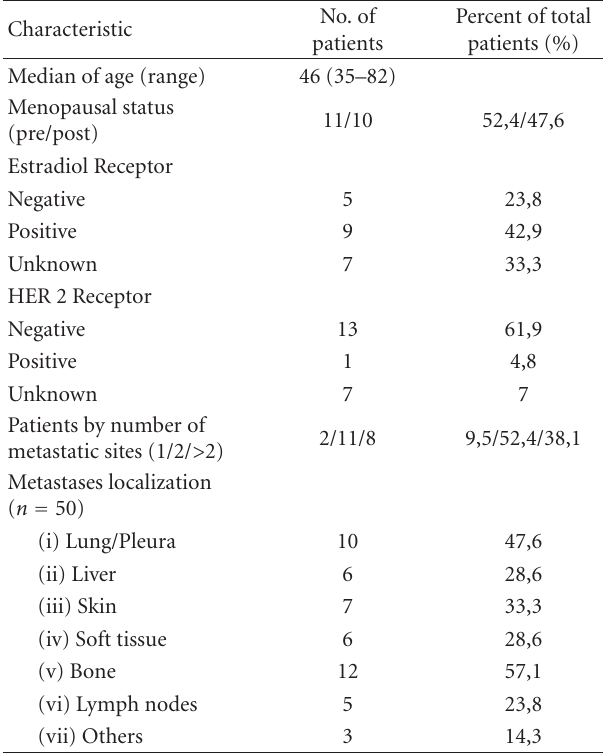
Table 1: Characteristics of patients included in the